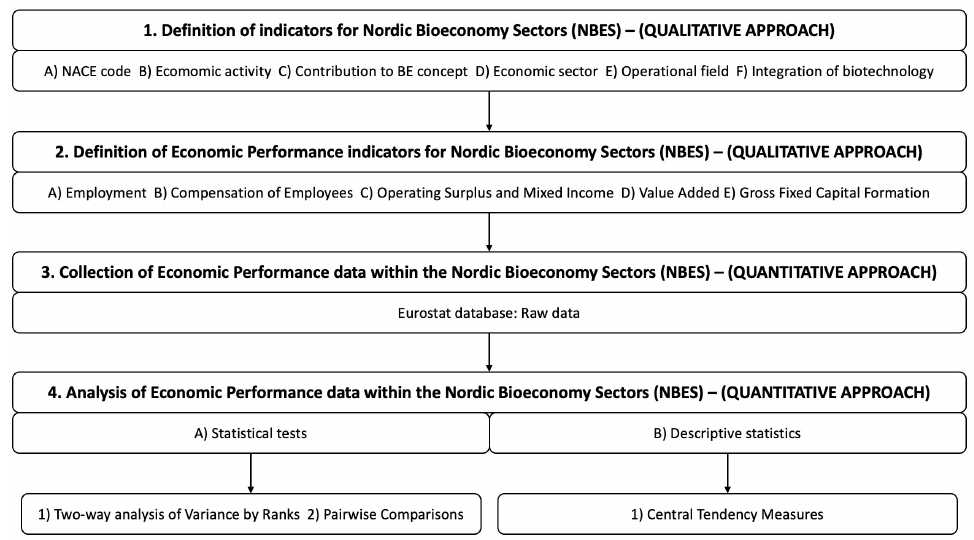
Figure 2. Diagram illustrates respective observation research stages in a cross-sectional analysis of the economic performance within the Nordic Bioeconomy Sectors